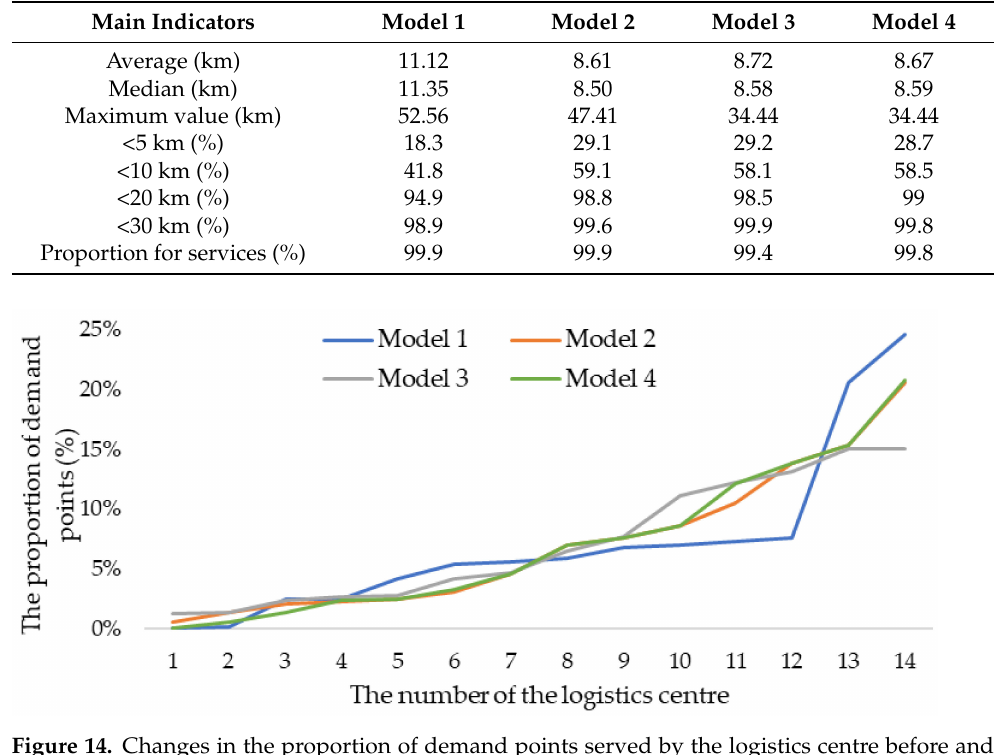
Figure 13. The distribution of travel distance of trucks. Table 6. Main indicators for comparison.